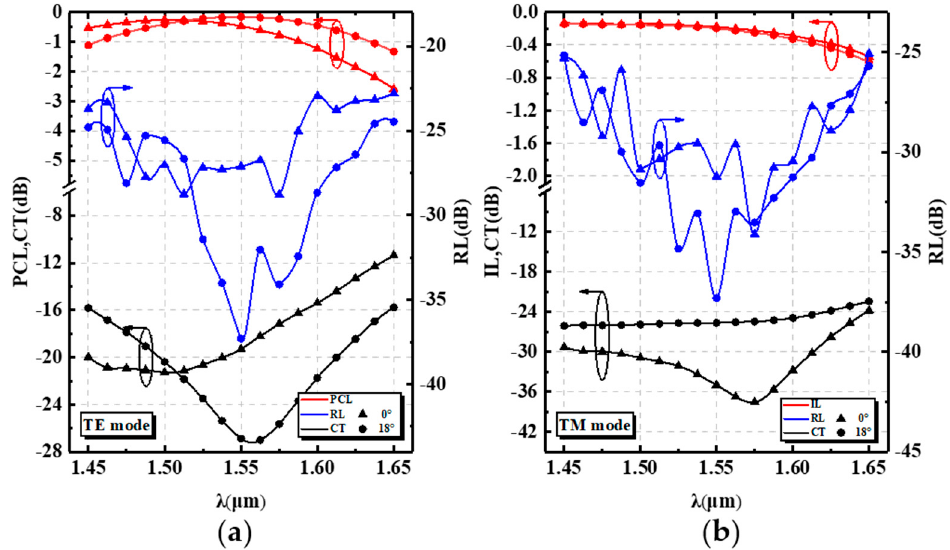
Figure 8. Comparison of the proposed device properties as functions of the wavelength at tilt angles of 0° and 18° for ( a ) the input TE mode and ( b ) TM mode.